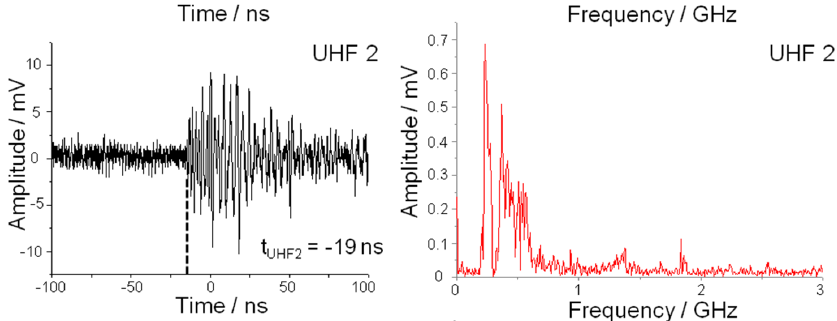
Figure 15. Measured UHF signal of probe “UHF 2” to prove broadband emission [29].